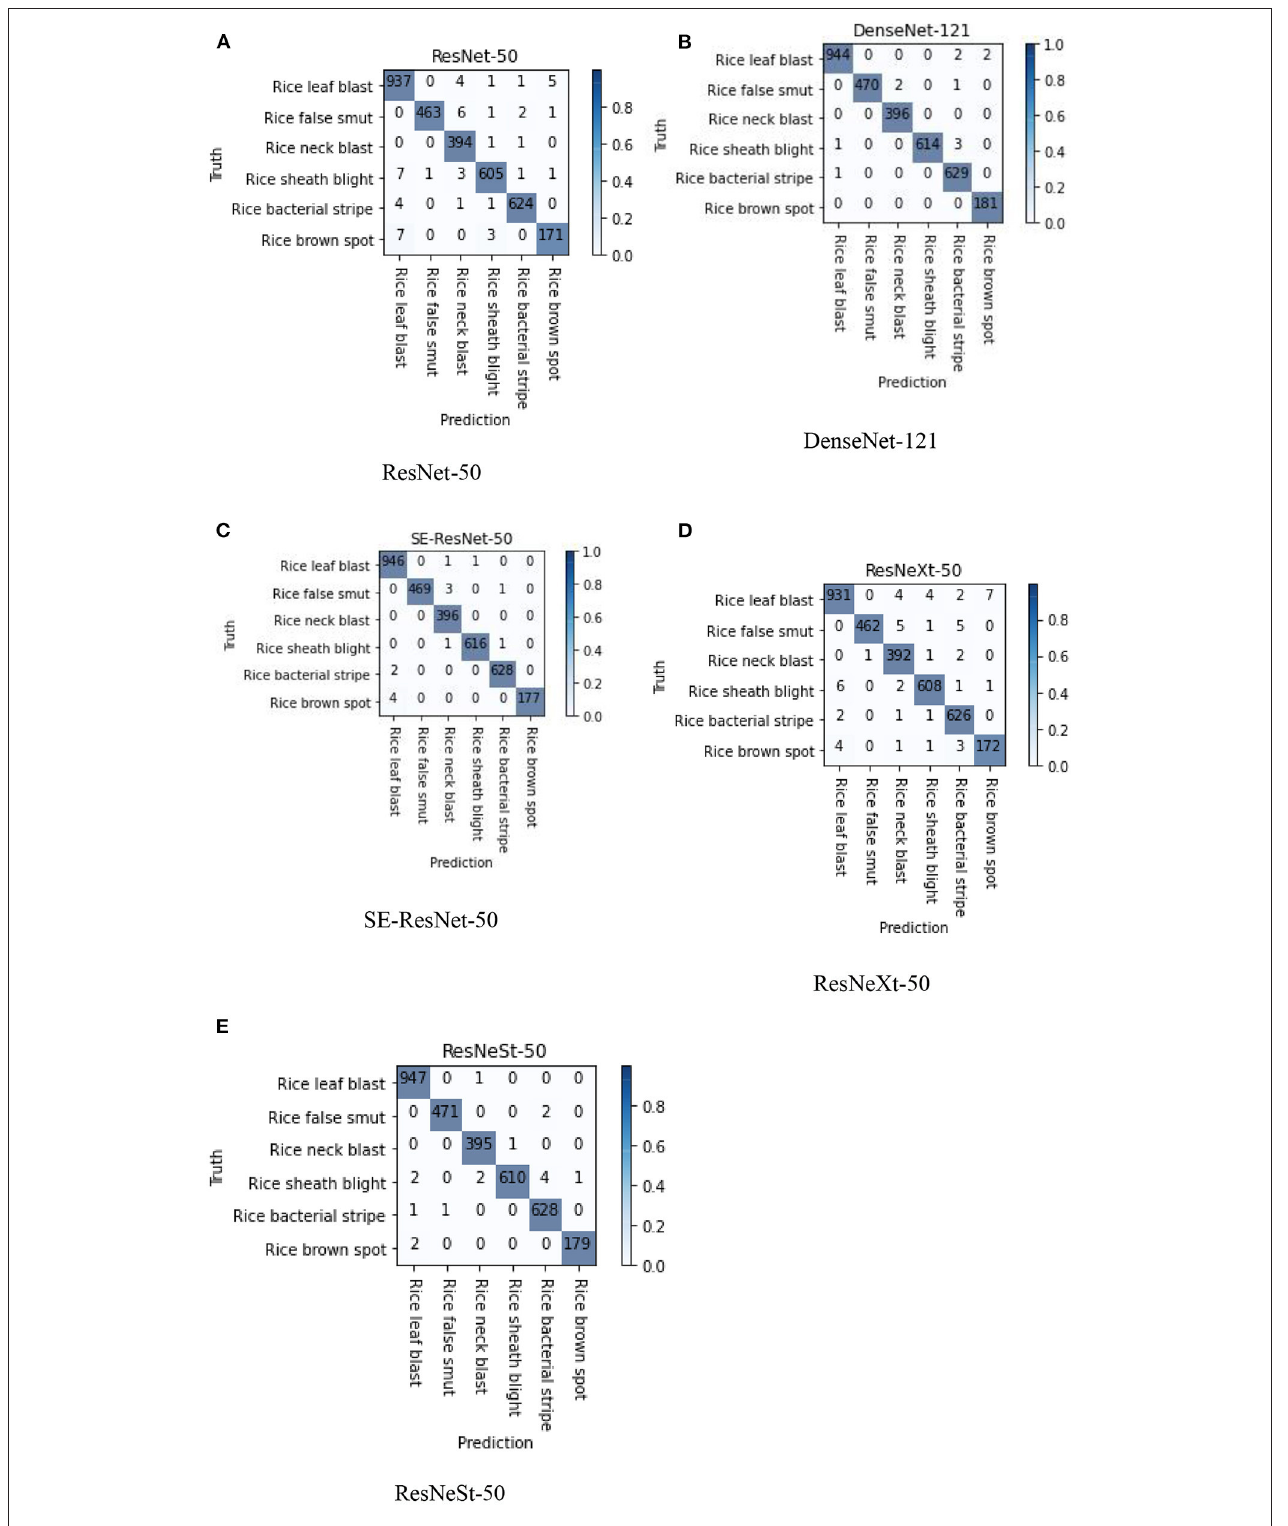
FIGURE 6 | Confusion matrixes of the five different submodels; images used were from the split test set. (A) ResNet-50, (B) DenseNet-121, (C) SE-ResNet-50, (D) ResNeXt-50, and (E) ResNeSt-50.